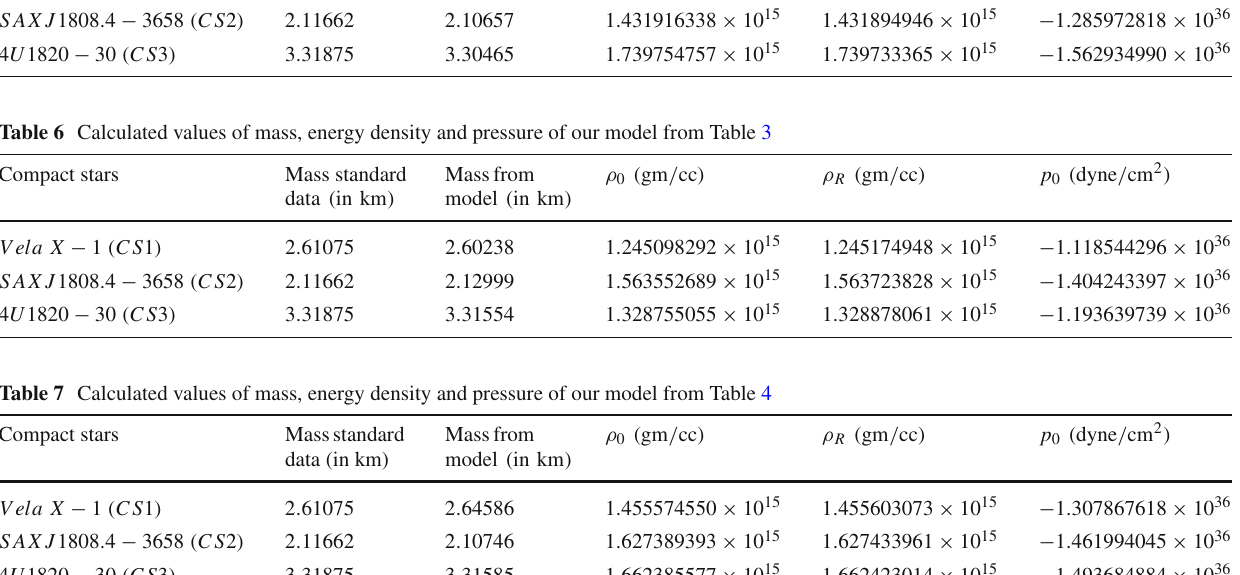
Table 5 Calculated values of mass, energy density and pressure of our model from Table 2 Compact stars Mass standard Massfrom data ( in km ) model ( in km )